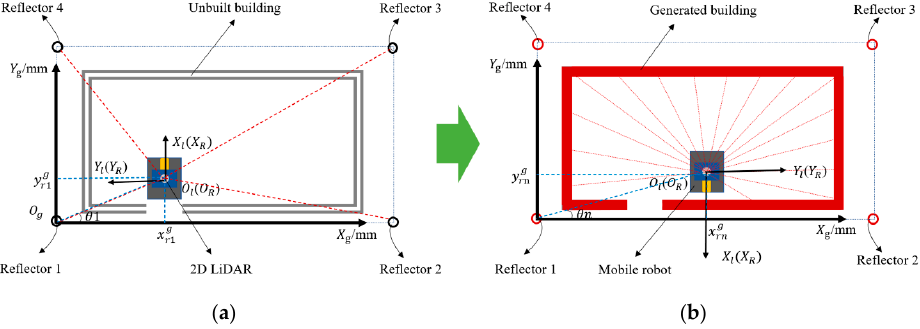
Figure 2. Construction of the ongoing scene for mobile robot. ( a ) Initial state of the mobile robot. ( b ) Completed state of the mobile robot.